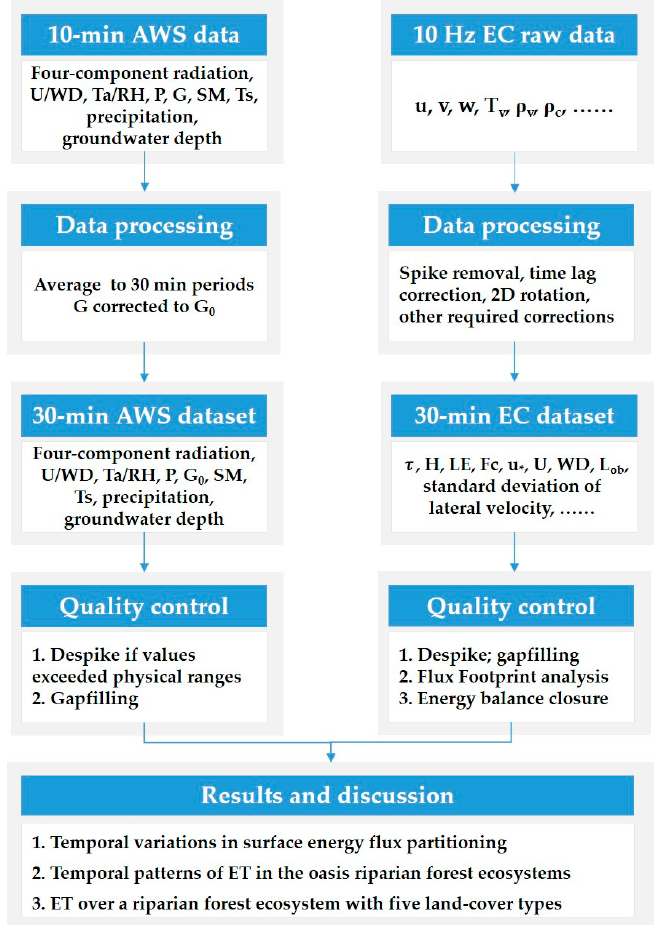
Figure 2. Flowchart of this study, including data processing and quality control. U: wind speed; WD: wind direction; Ta: air temperature; RH: relative humidity; P: pressure; G: soil heat flux; SM: soil moisture; Ts: surface and soil temperature; G 0 : surface heat flux; u, v, w: three-dimension wind speed; T v : sonic virtual temperature; ρ v: water vapor; ρ c: carbon dioxide; τ : momentum flux; H: sensible heat flux; LE: latent heat flux; Fc: carbon dioxide flux; u * : friction velocity; and L ob : Obukhov